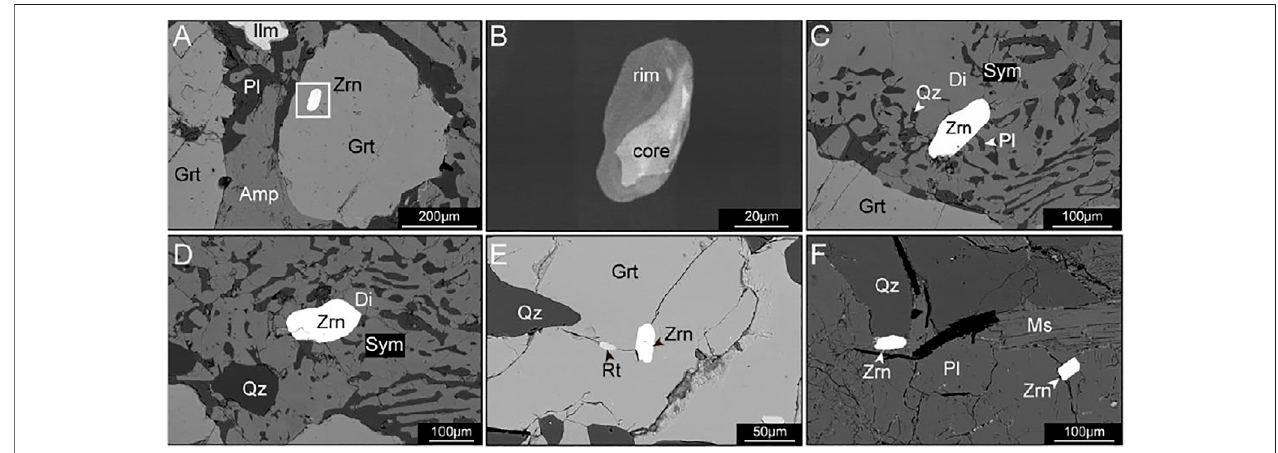
FIGURE4| Back-scatteredelectron(BSE)imagesshowingmicrostructureofzirconineclogites (A,C,D) andgneiss (E,F) ; (B) Cathodoluminescence(CL)imageof zircon inclusion in garnet enlarged for the square of (A)